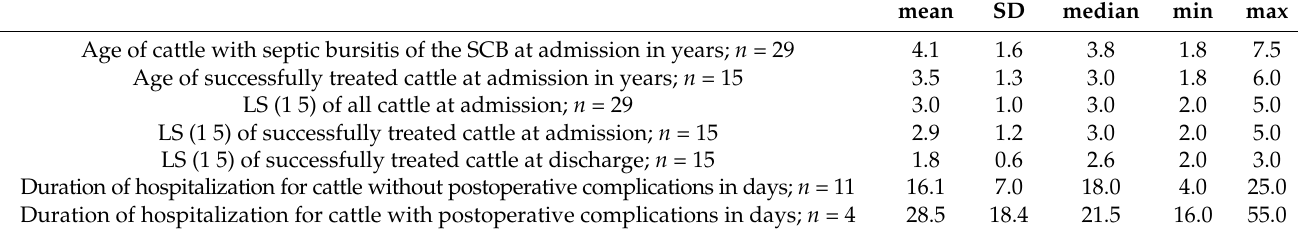
Duration of hospitalization for cattle without postoperative complications in days; n = 11 Duration of hospitalization for cattle with postoperative complications in days; n =